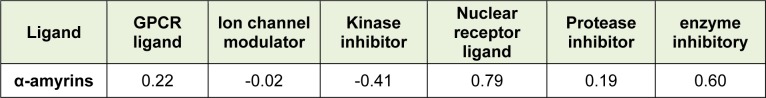
Bioactivity score (drug-likeness property) analysis of α-amyrins using Mol inspiration online software tool